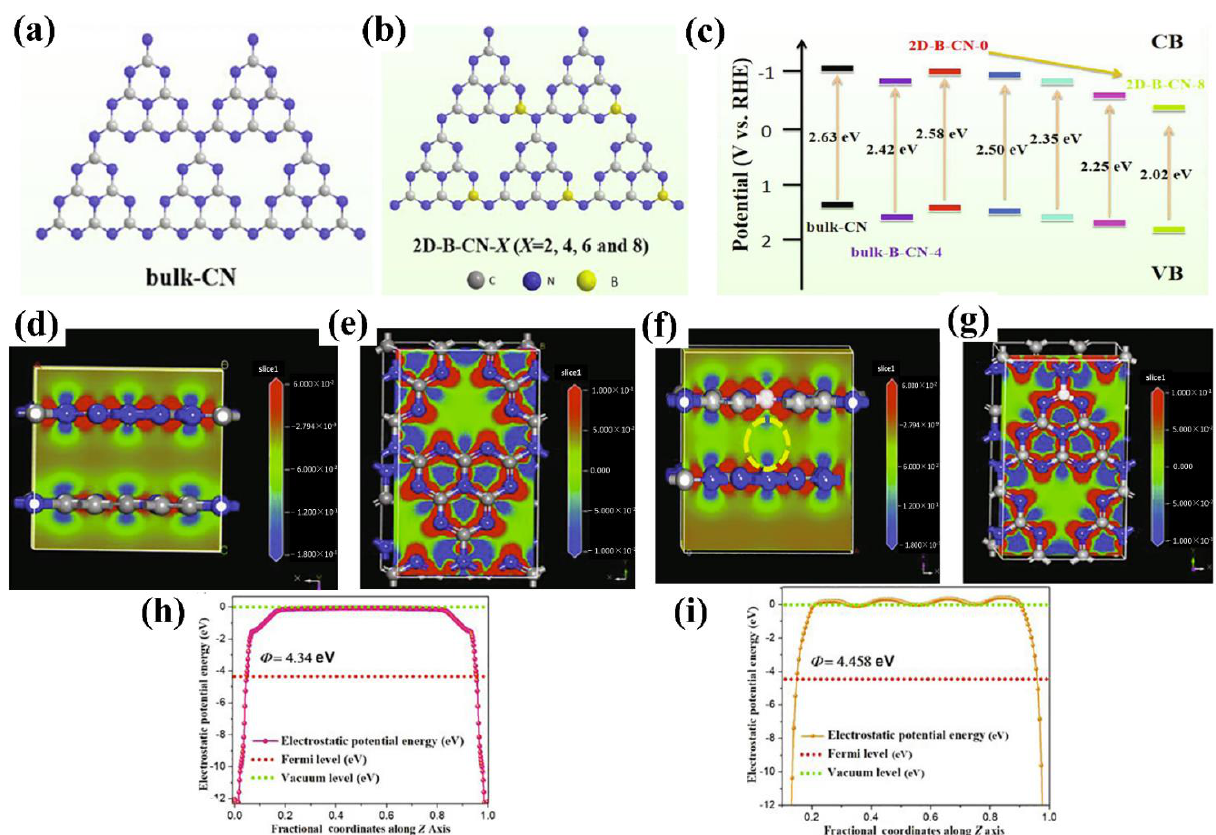
Figure 10. ( a , b ) The detailed structures of bulk-CN and 2D B doped g−CN (2D-B-CN) samples. ( c ) schematic energy level diagrams. ( d , e ) Electron density difference (EDD) plots and ( h ) work function of bulk-CN. ( f , g ) EDD plots and ( i ) Work function of 2D-B-CN (C, N and B atoms are labelled in gray, blue, and white, respectively). Reprinted with permission from ref. [112] Copyright 2022 Elsevier.